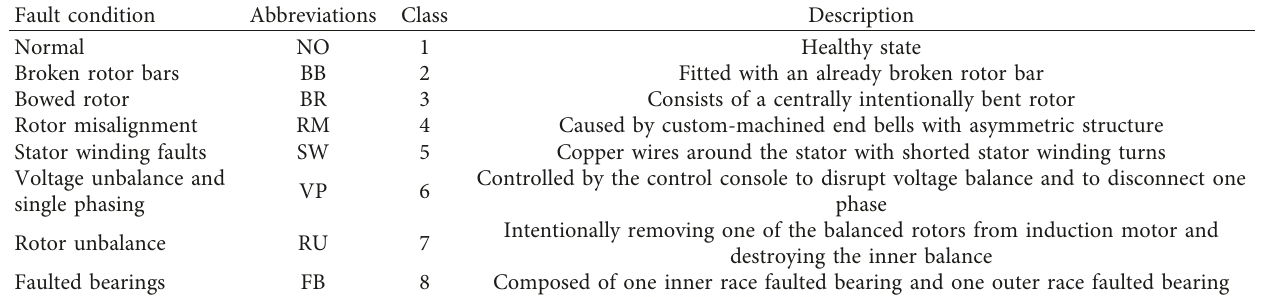
Figure 1: The test platform and data acquisition devices. (a) Test rig: drivetrain diagnostic simulator (DDS). (b) Data acquisition card NI- 9234. (c) Acceleration sensor BW-BJ14530. Table 1: Motors with 8 fault types in tests.